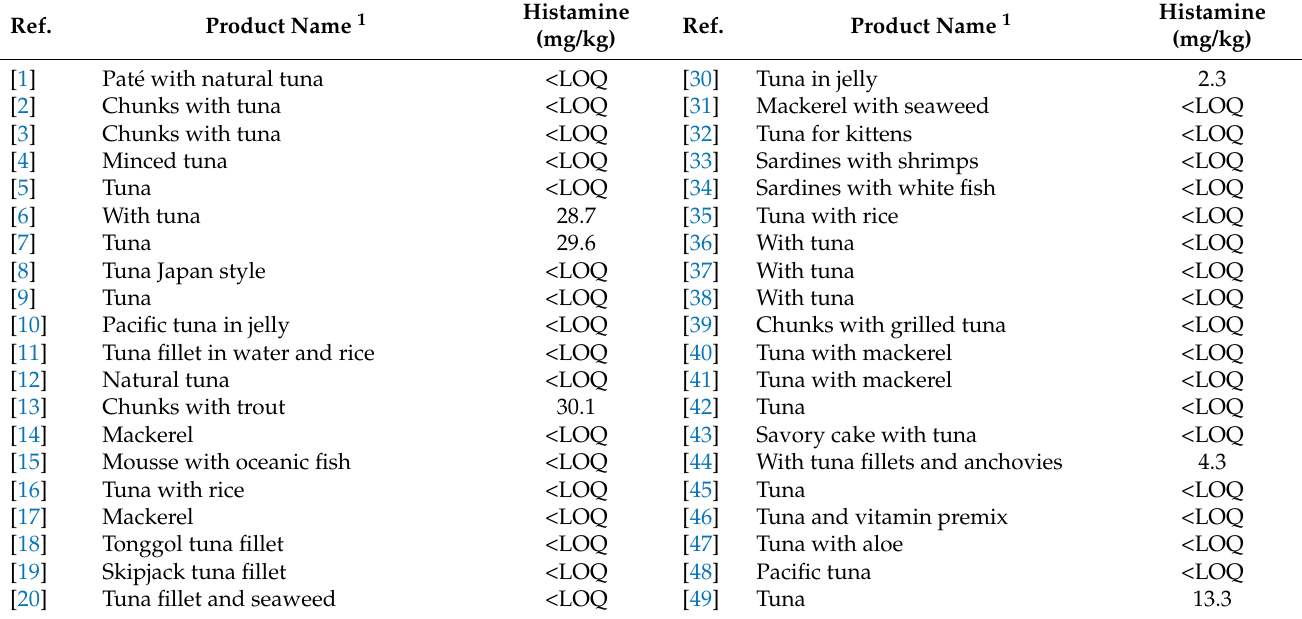
Table 4. Pet-food samples and histamine